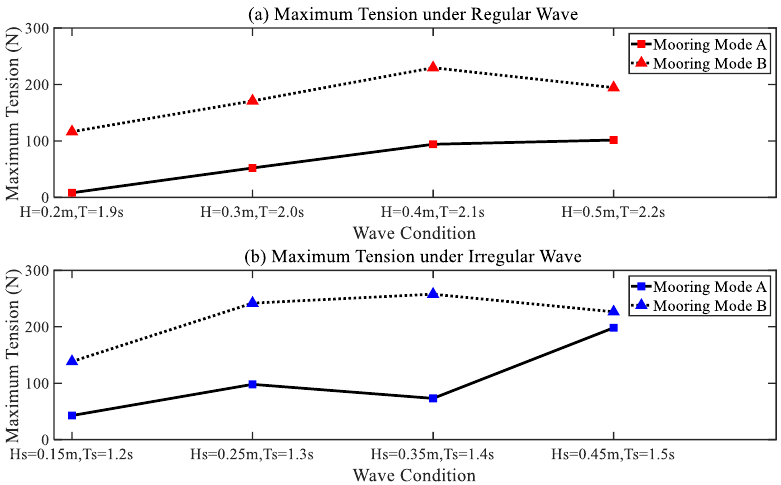
Figure 8. The maximum tension on the anchor line of the single-anchor line mooring mode.